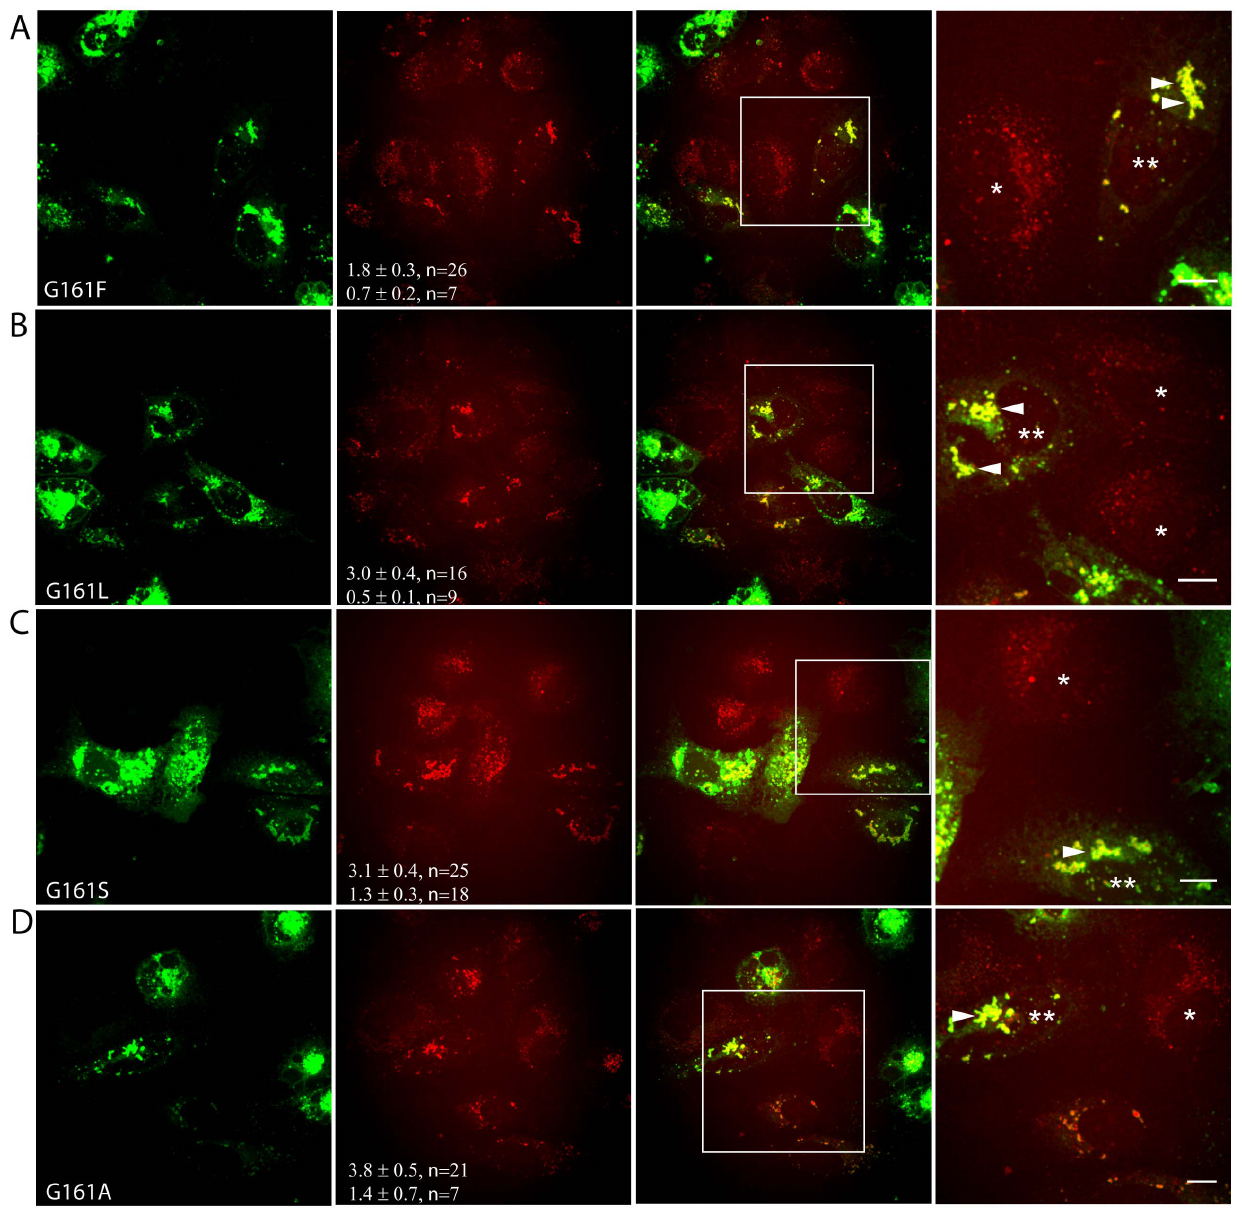
Figure 3. Simultaneous CARS and TPF microscopy captures LD changes induced by single amino acid mutations in GFP-tagged DII- core 161 expressing Huh-7 cells. All images were collected approximately 20 hours after Huh-7 cells were transfected with (A) DII-core G161F , (B) DII- core G161L , (C) DII-core G161S , and (D) DII-core G161A . CARS imaging identifies DII-core 161 induced LD biogenesis and redistribution towards the perinuclear region under the expression of all DII-core 161 mutants (A–D, panel 4, arrowheads). The two values in panel 2 represent the average LD volume for cells expressing DII-core 161 (top value, double asterisks) and non-expressing DII-core 161 cells (single asterisks) within the same field of view (bottom value) as measured by voxel analysis. The error represents standard error of the mean. The n represents the number of cells that were quantified for LD density. This experiment was conducted under two biological replicates. Panel 4 is a magnified image selected by a region of interest from the merged image to project a clearer view of colocalization between DII-core 161 mutants and LDs. The scale bar represents 10 m m. 48–72 hours during the time span of infection, LD mobility LDs at the Extreme Perinuclear Region Demonstrate measurements required video-rate imaging that is attainable over Limited Mobility a shorter time course with averaging of many trials. Two general localizations of DII-core coated LDs were revealed by CARS and DIC imaging for wild-type and all the DII-core mutants: scattered throughout the cell (Figure S5, white arrow- heads), and tightly aggregated in the perinuclear region (Figure S5, red arrowheads). Perinuclear LD aggregation was not observed in